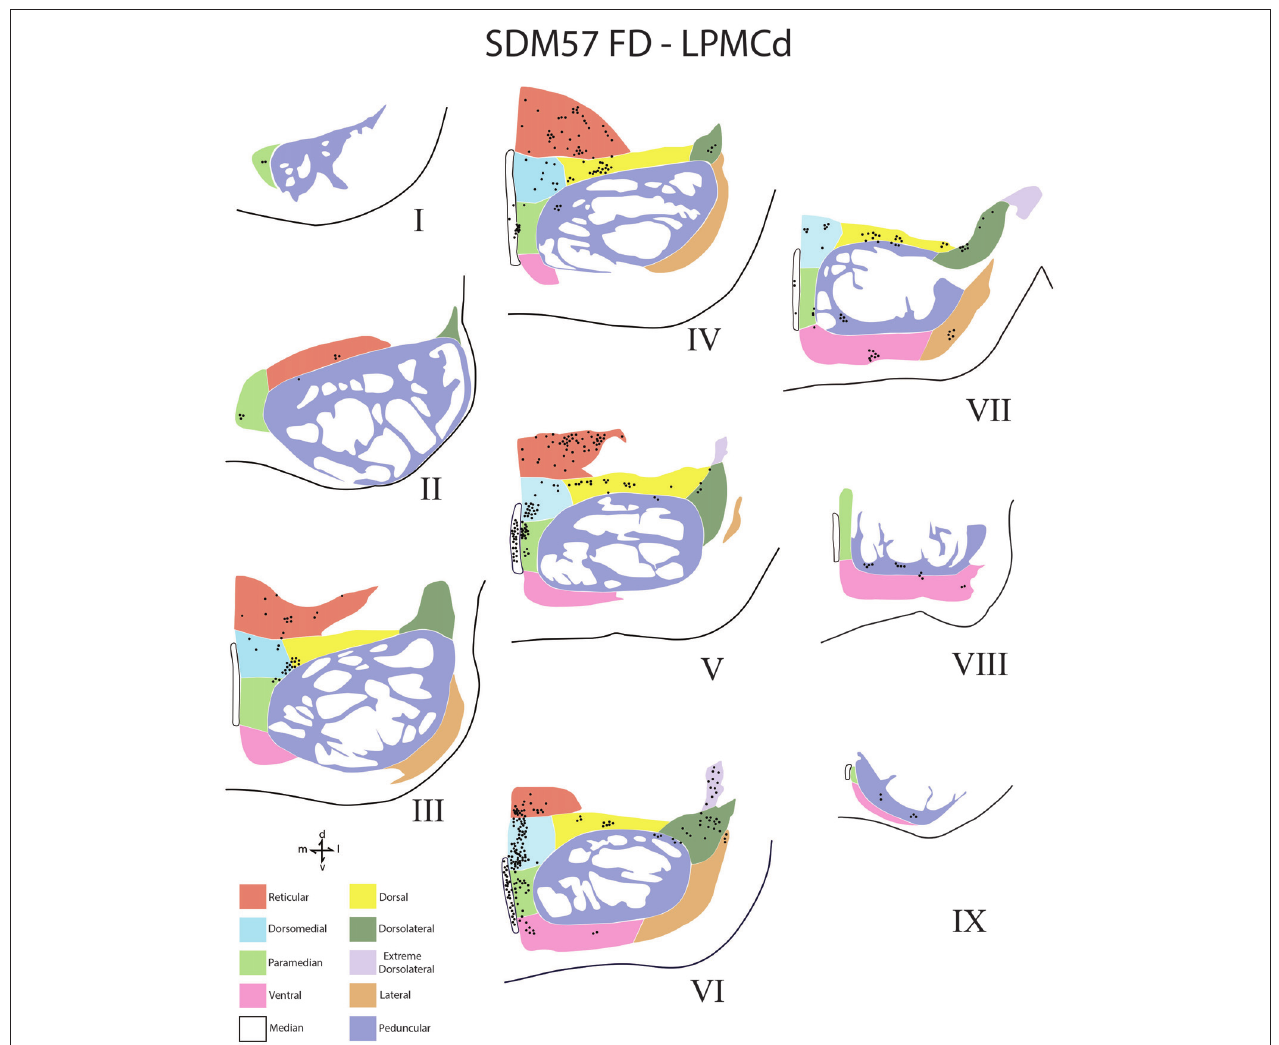
FIGURE 5 | Line drawings of transverse sections depicting the topographical distribution of labeled terminals (black dots) from superior (I) to inferior (IX) levels of the basis pontis in case SDM57 following an injection of FD into the caudal region of LPMCd. Note terminal labeling is primarily located in the dorsal and medial regions of the basis pontis and is particularly prominent at levels IV through VII. Abbreviations: d, dorsal; l, lateral; m, medial; v,